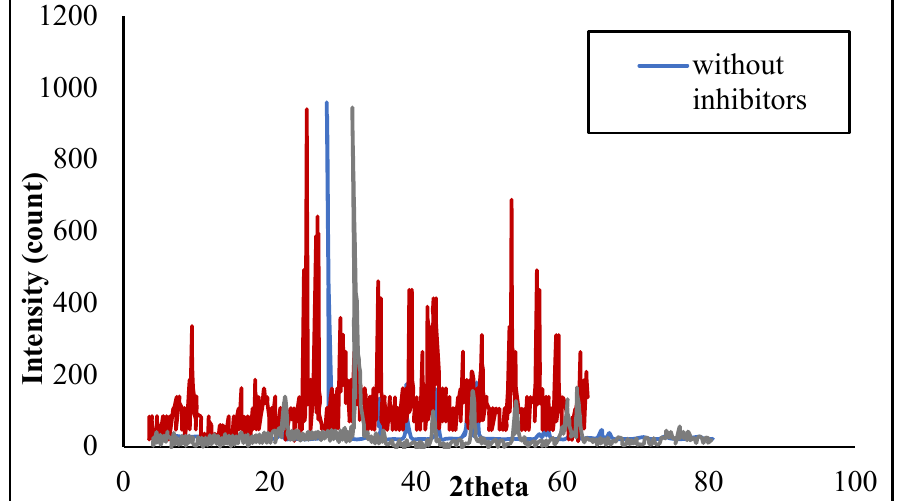
Figure 13. XRD of inhibited scaled TFCNF membrane without inhibitor; with scale inhibitor DPE injection; and with scale inhibitor OAE injection.